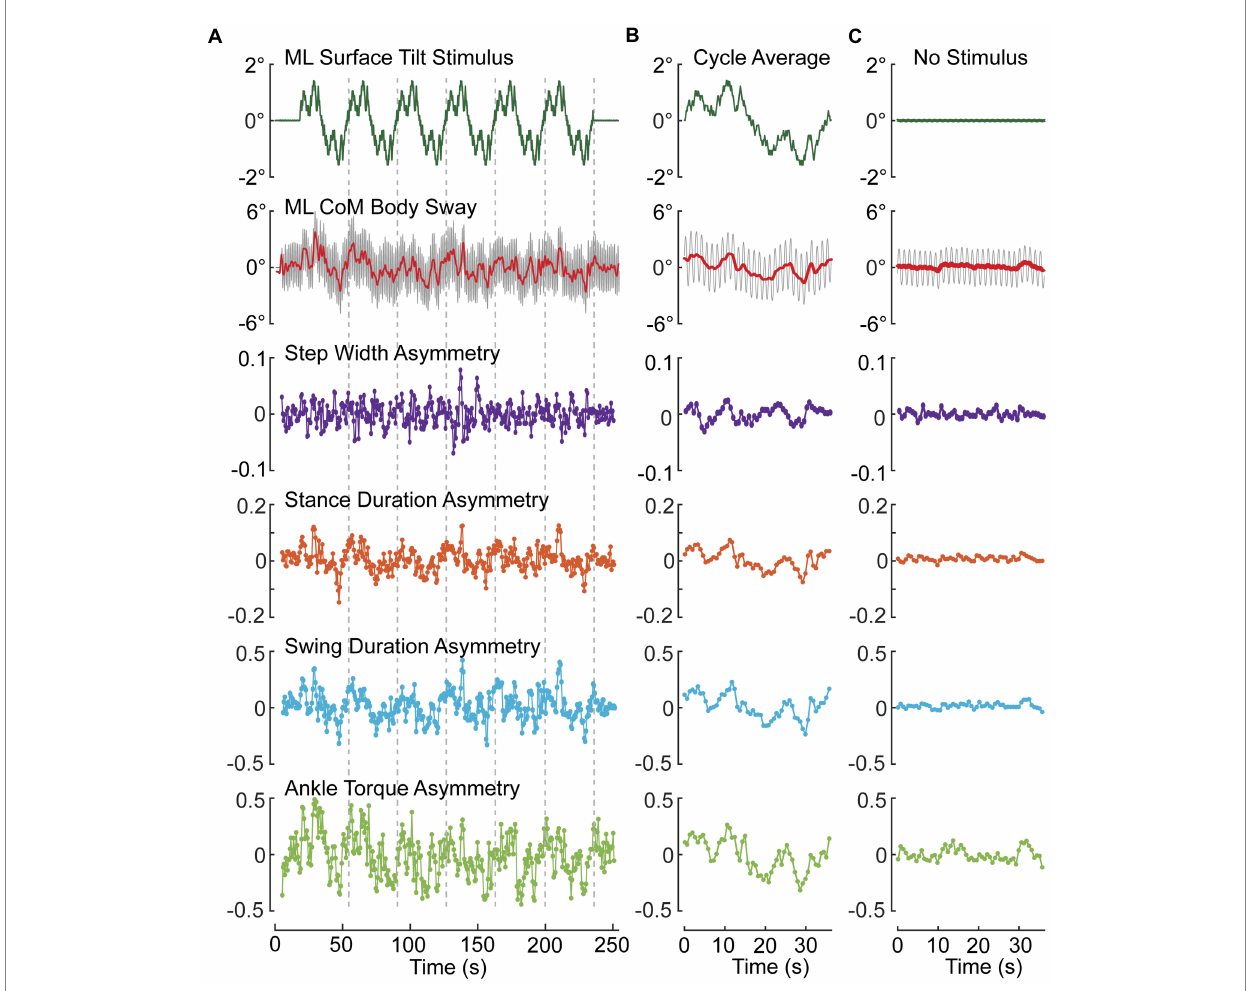
FIGURE 6 Example data from one subject showing modulation of ML CoM sway and asymmetry measures during an eyes-closed stepping-in-place trial on a tilting surface that rotated laterally during application of six cycles of a pseudorandom stimulus with 3 ° peak-to-peak amplitude (A,B) and average results from an eyes closed trial on a fixed, unmoving surface (C) . (A) Shows the entire time series of stimulus, path-corrected center-of-mass (CoM) sway and the four asymmetry measures. (B) Shows measures averaged over the last five 36.3-s duration cycles of the pseudorandom stimulus. (C) Shows cycle-averaged results for an eyes-closed stepping-in-place trial on a fixed surface demonstrating the lack of modulation of asymmetry measures compared to perturbed conditions. Stepping during both test conditions was metronome paced to give 56 steps per 36.3 s pseudorandom cycle (92.56 beats/min). The red line through the center of oscillating CoM motion (gray) is the 0.5-Hz lowpass filtered CoM